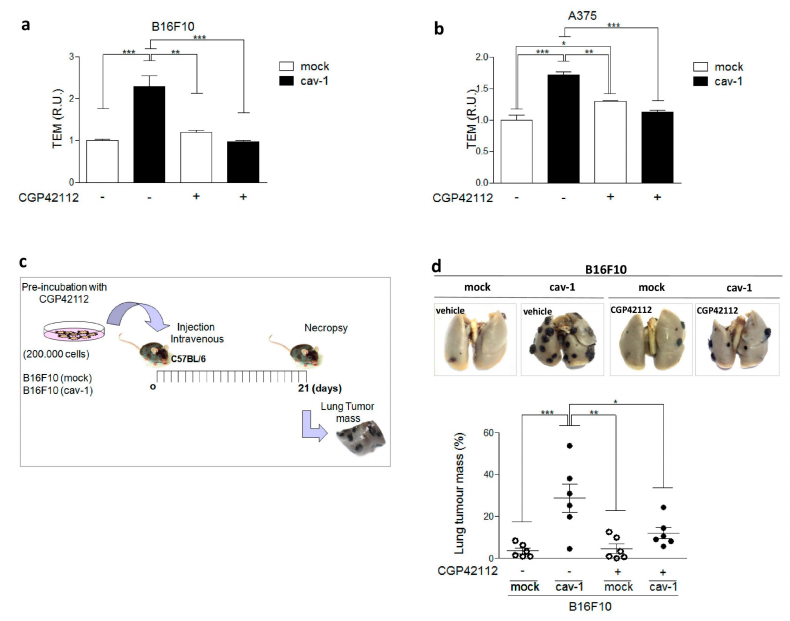
Figure 5. Angiotensin II type 2 receptor (AT2R) activation decreases transendothelial migration and metastasis of melanoma cells. ( a ) and ( b ) Transendothelial Migration (TEM) following pretreatment for 30 min with N- α − Nicotinoyl-Tyr-Lys-(N- α -Z-Arg)-His-Pro-Ile (CGP42112; 1 µ M) or in controls was performedusingB16F10orA375cells, respectively, expressingornotcaveolin-1(CAV1). Valuesobtained were normalized to the average values obtained for controls without treatment (N = 3) (mean ± standard error of mean). ( c ) Scheme illustrating the sequence of events in metastasis assays. For metastasis assays, B16F10(cav-1) or B16F10(mock) cells were pretreated with CGP42112 (1 µ M) for 30 min. Metastasis in C57BL / 6 mice was evaluated as described. ( d ) Representative images of lungs showing metastasis 21 d after inoculating the mice with the cells are shown in the upper panel. The graph shows a quantitative analysis of lung metastasis obtained by expressing lung tumor mass as a percentage of total lung mass. Data represent the (mean ± standard deviation) of three independent experiments with a total of 8 mice per condition. Results obtained were compared statistically as explained in Materials and Methods. Significant di ff erences are indicated as *** p ≤ 0.001, ** p ≤ 0.01, * p ≤ 0.05. (R.U., relative